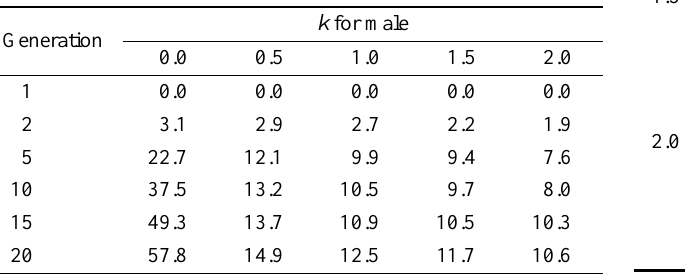
Table 2. The percentage of increase in the rate of inbreeding with different k values for male when k for female = 0 Generation